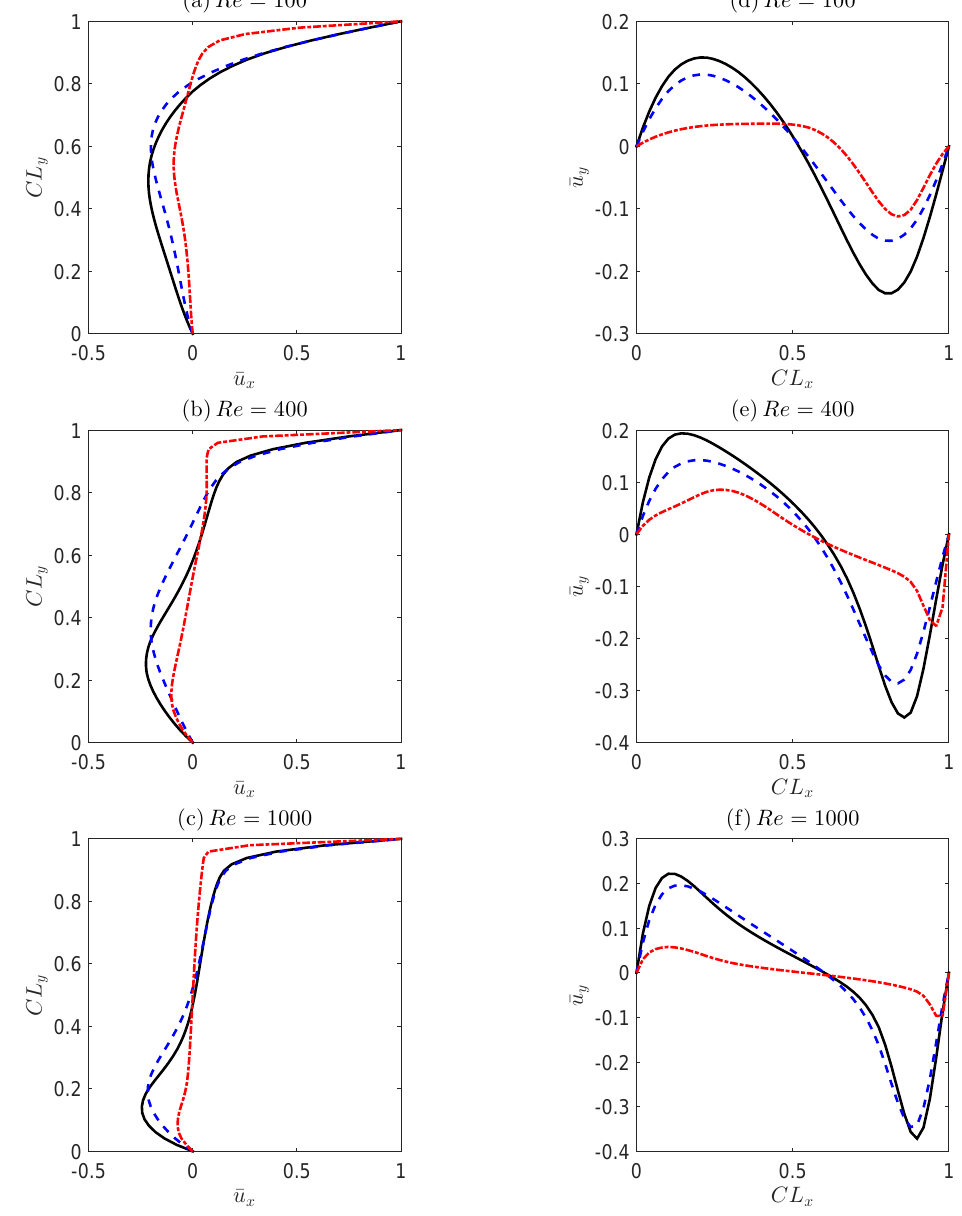
Figure 8. Normalised x -components of velocity profiles for aspect ratio δ = 1 and Reynolds numbers ( a ) Re = 100; ( b ) Re = 400; ( c ) Re = 1000, and normalised y -components of velocity profiles for aspect ratio δ = 1 and Reynolds numbers; ( d ) Re = 100; ( e ) Re = 400; and ( f ) Re = 1000;— n = 1 (in black),— n = 0.9 (in blue), and — n = 0.5 (in